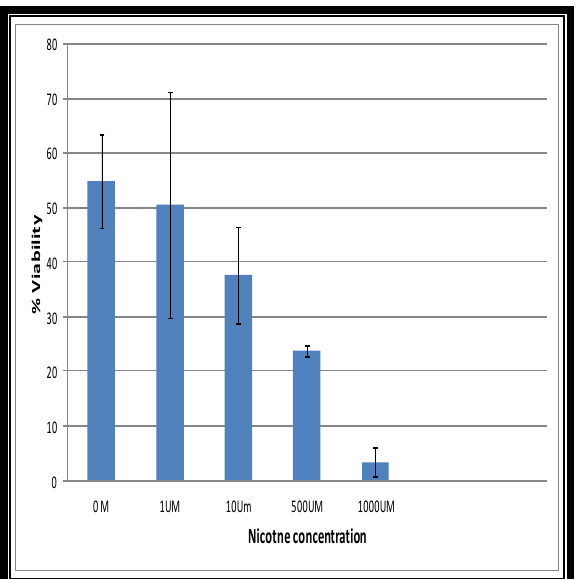
Figure 1: Cytotoxic effects of nicotine on H460 lung cancer cells by MTT assay with wave length of 570 nM.